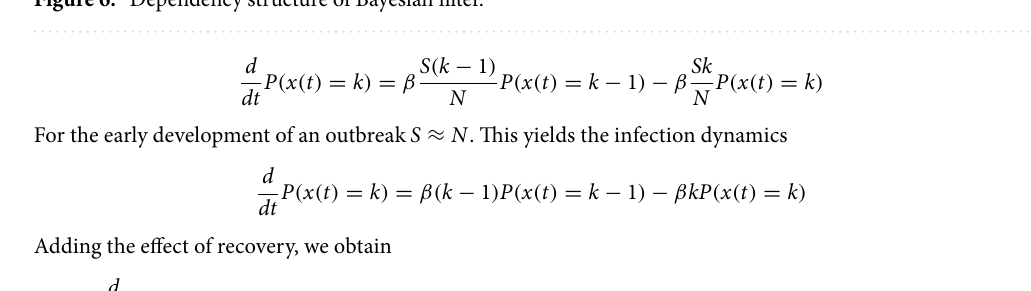
Figure 6. Dependency structure of Bayesian